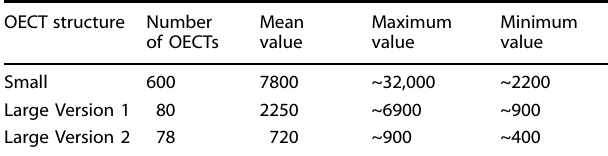
Fig. 5 Histogram of the overall behavior of the two sets of large OECTs. a and b show the ON and OFF current distributions, c shows the ON/OFF current ratio distributions of 158 large OECTs, d shows the current distribution of the gate current in the OFF state. Table 1. Summary of the ON/OFF current ratio for the three OECT